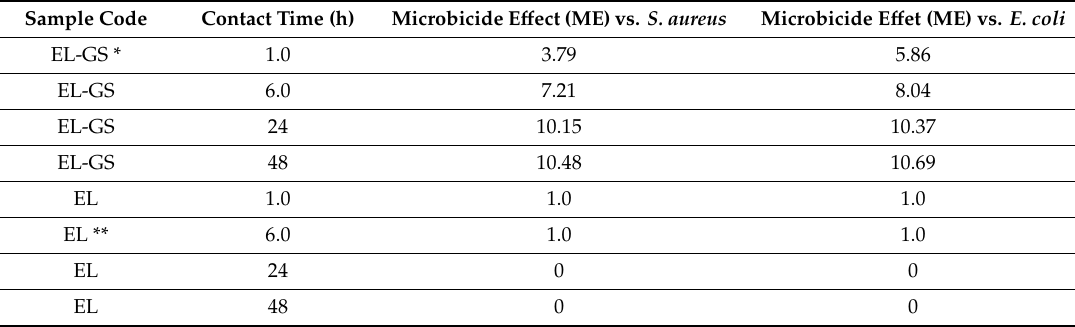
Table 3. Antibacterial activity of EL-GS evaluated against S. aureus and E. coli.